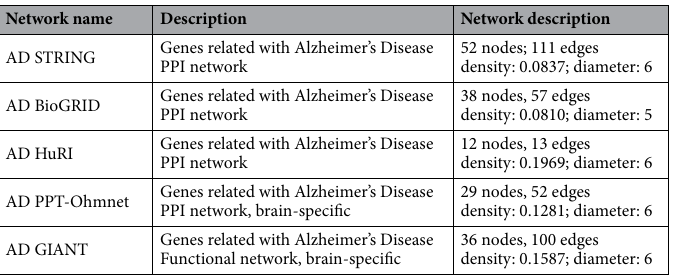
Table 1. Properties of the biological